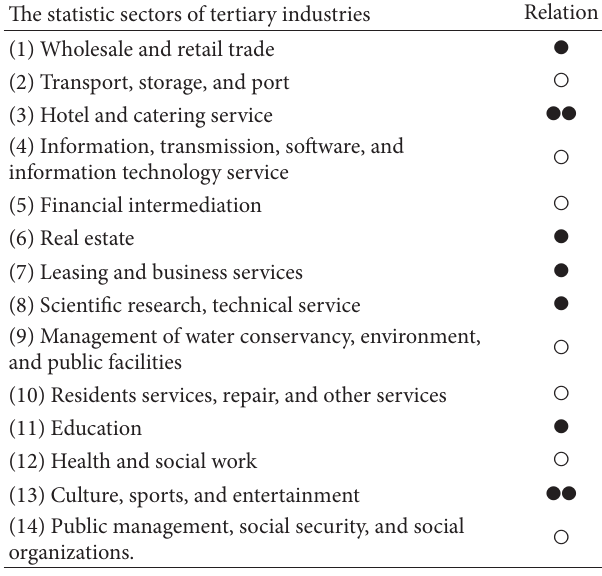
Table 2: The service relation between industrial heritages and the statistic sectors of tertiary